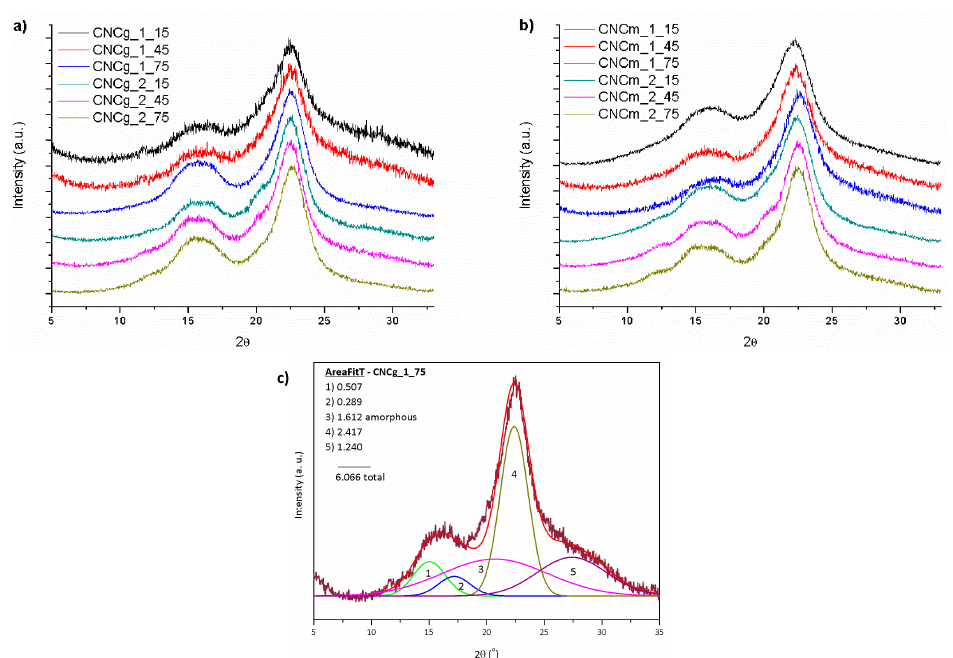
Figure 10. XRD profiles for the CNC obtained from ( a ) 1 × and 2 × bleached gravata fiber, ( b ) 1 × and 2 × bleached macauba fiber and ( c ) an example of deconvoluted peaks of CNCg_1_75. Polymers 2019 , 11 , x FOR PEER REVIEW